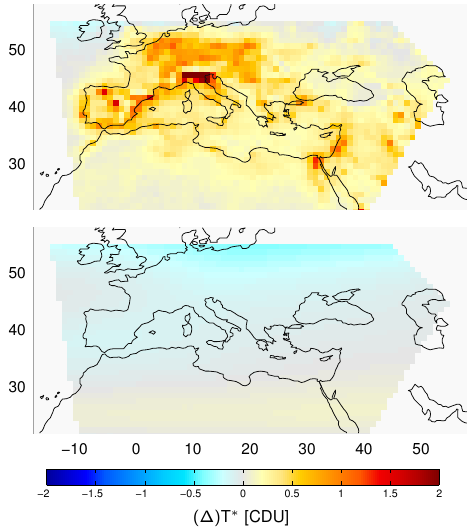
Figure 17. Performance of STREAM on “S4 data” (i.e., OMI mea- surements clipped to the area covered by S4) for January 2005. The top panel displays the resulting TR, the bottom panel shows the dif- ference to the TR resulting from full OMI data as shown in Fig. 5. The area covered by S4 in winter has been taken from Courrèges- Lacoste et al.